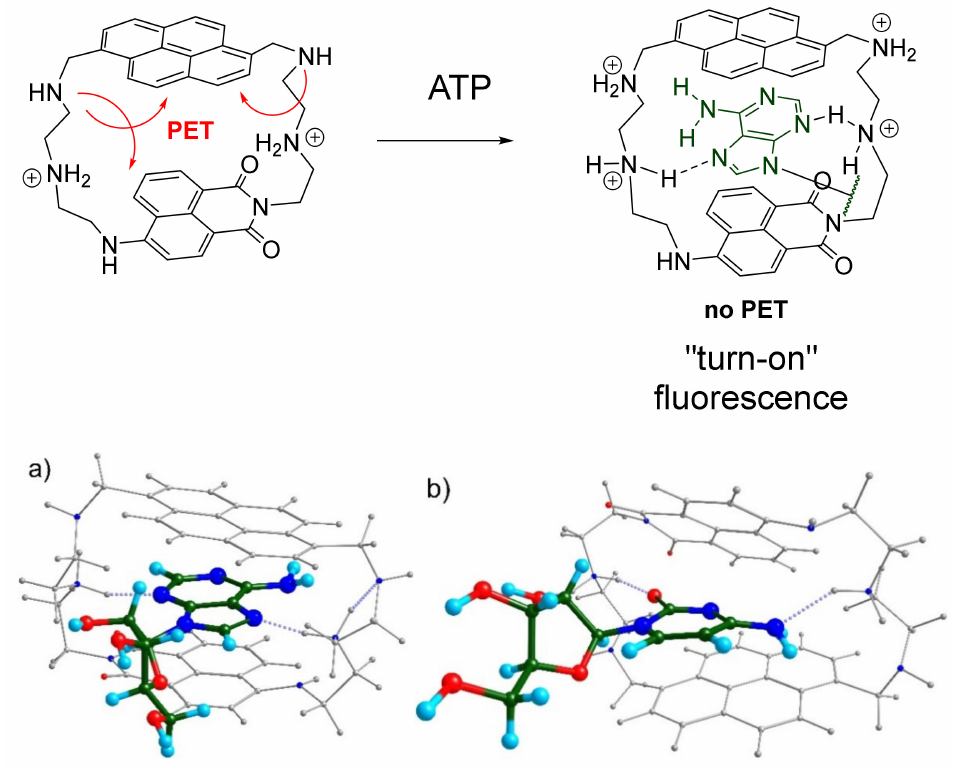
Figure 4. Proposed mechanism of the “turn-on” fluorescent response of 7 towards ATP. Optimized molecular structures of 7 with ( a ) adenosine and ( b ) cytidine, showing hydrogen bonding interactions of nucleobases with amine